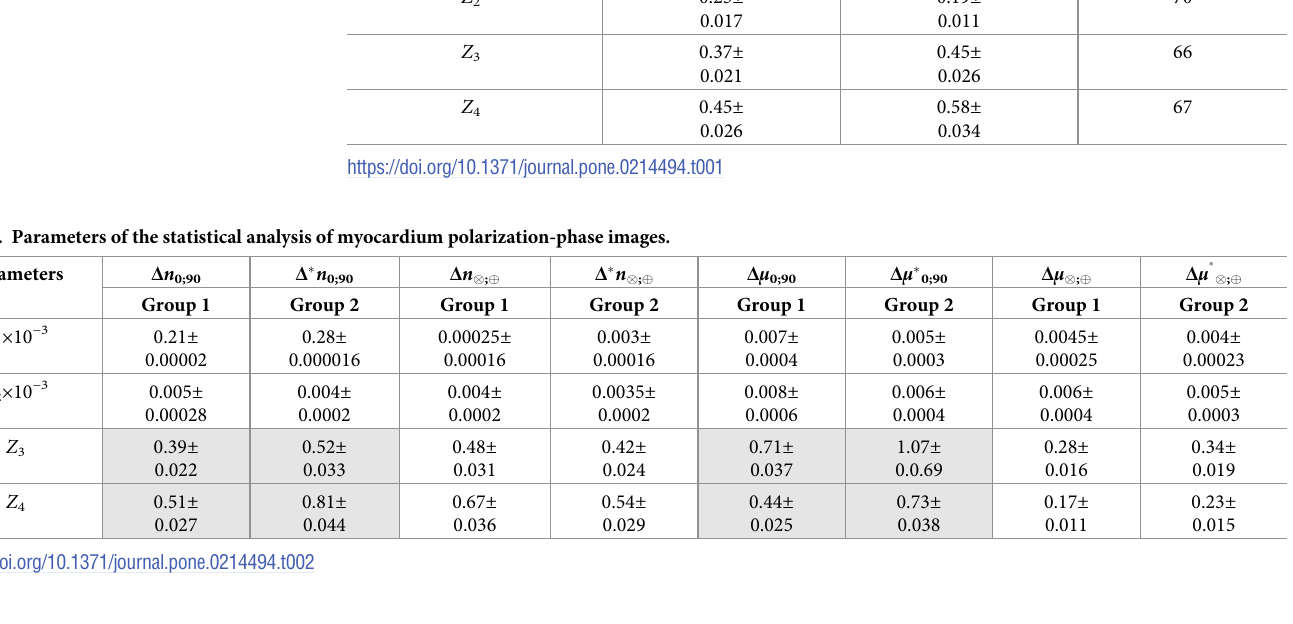
Table 3. Operational characteristics of the method of the Mueller-matrix images of the optical anisotropy of the histological sections of the myocardium biopsy.